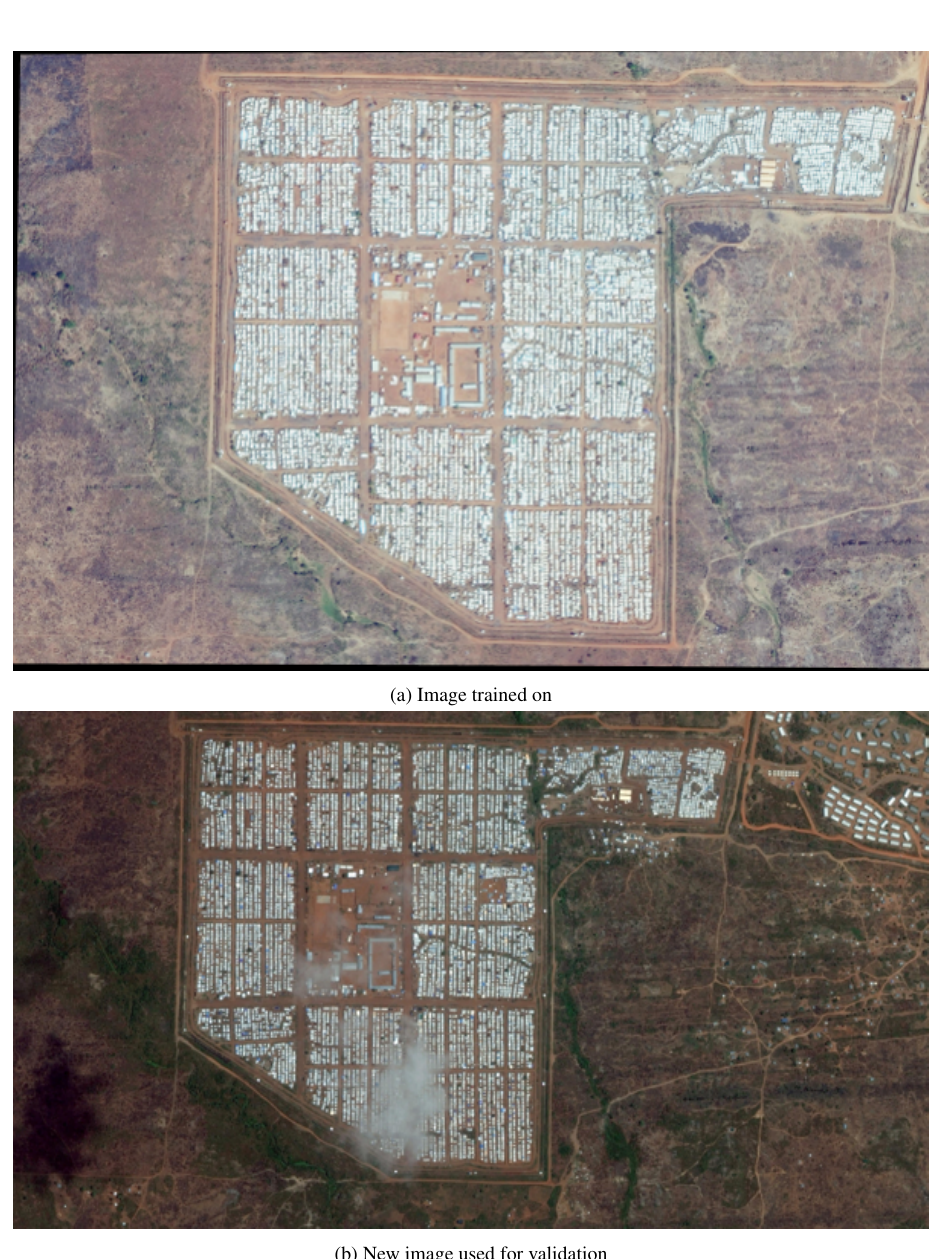
Figure 2. Example of one image (a) trained on and used in validation sets v orig and the new image (b) used in the validation sets v new. Both images show the refugee camp Juba in South Sudan ate the extent of one dwelling. The results of the region grow- ing algorithm are then filtered to eliminate bad regions. Around each region, a bounding box is defined and stored in the MS COCO-annotation format (Lin et al.,